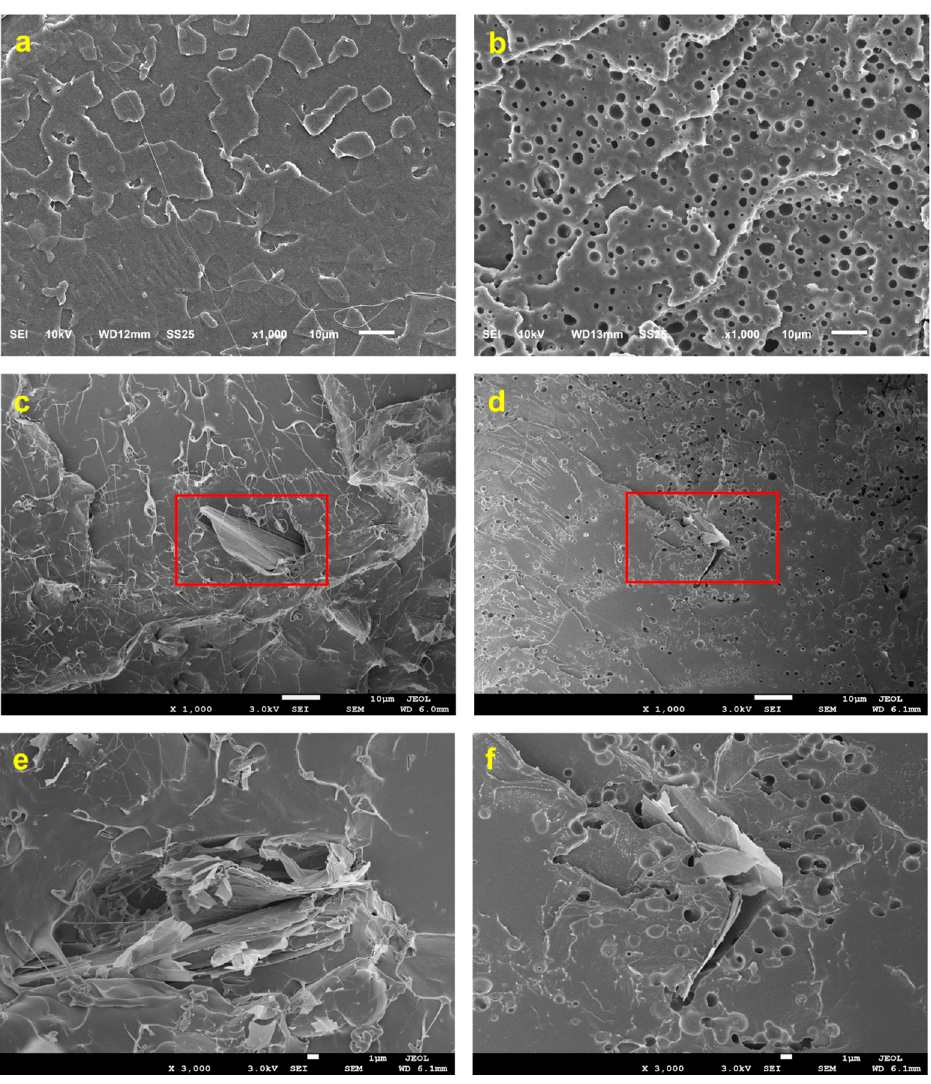
Figure 1. SEM images of film samples showing the polymer domains and distribution of GRH nanoplatelets: ( a ) PLA-c; ( b ) PLA- g -TPCS; ( c ) PLA-GRH ( × 1000); ( d ) PLA- g -TPCS-GRH ( × 1000); ( e ) PLA-GRH ( × 3000); ( f ) PLA- g -TPCS-GRH ( × 3000).